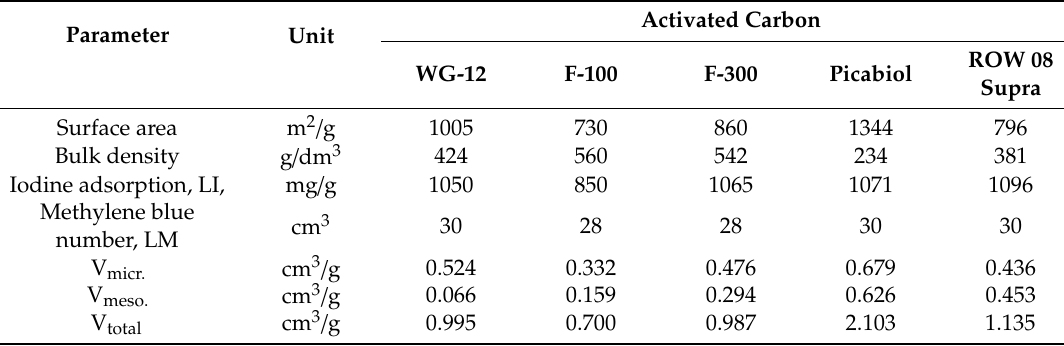
Table 4. Physical and chemical properties of activated